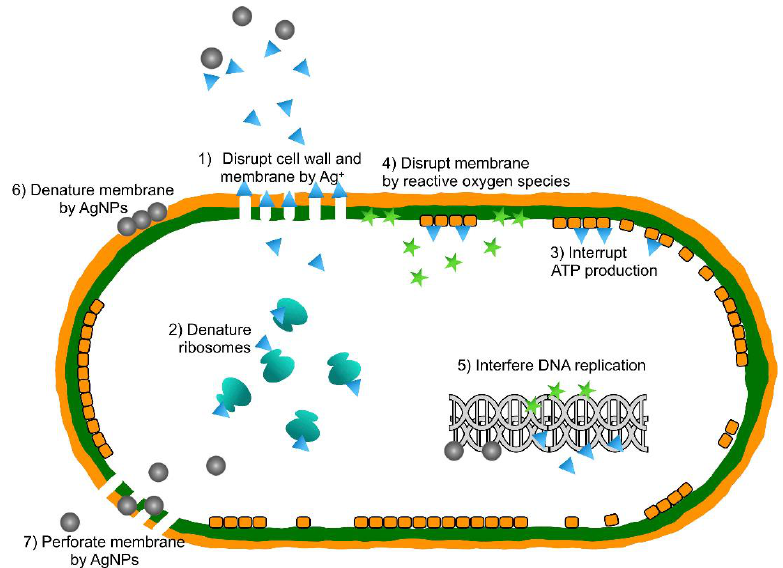
Figure 1. The possible antibacterial mechanisms of AgNPs. Reproduced with permission from ref